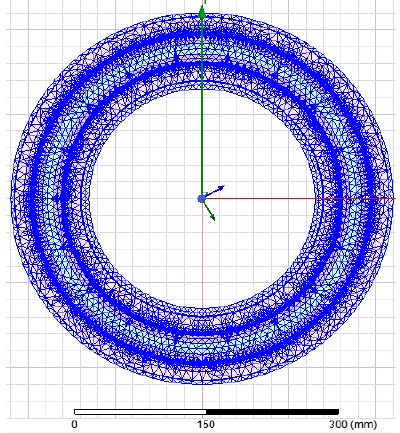
Figure 8. Mesh division of the permanent magnet braking device.